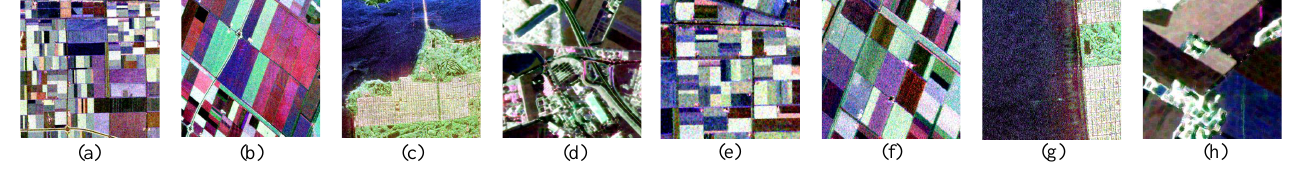
Figure 9. Some examples of patches used for polynomial curve fitting from data sets 1–4. ( a – d ) are the patches of 512 × 512 pixels, and ( e – h ) are the patches of 256 × 256 pixels. The values of complexity C are 0.4536, 0.4582, 0.3196, 0.5612, 0.4503, 0.3814, 0.1616, and 0.3545,